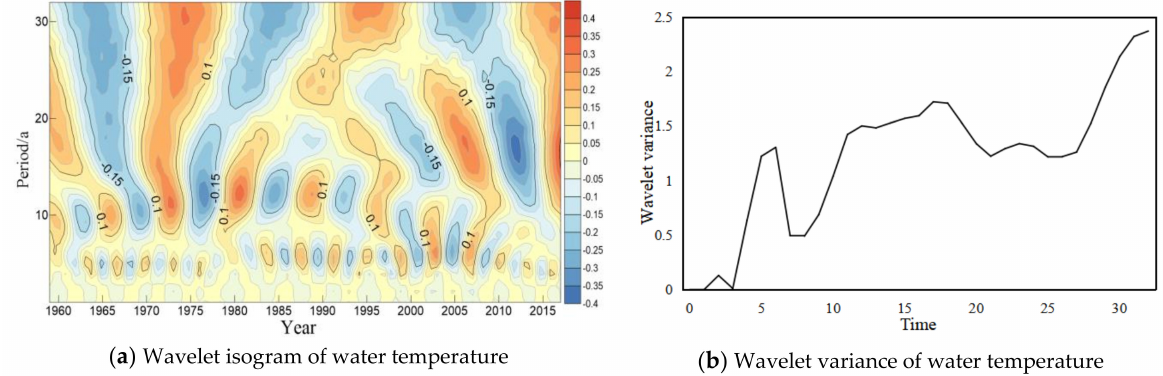
Figure 4. Wavelet isogram ( a ) and wavelet variance map ( b ) of water temperature at Cuntan station.